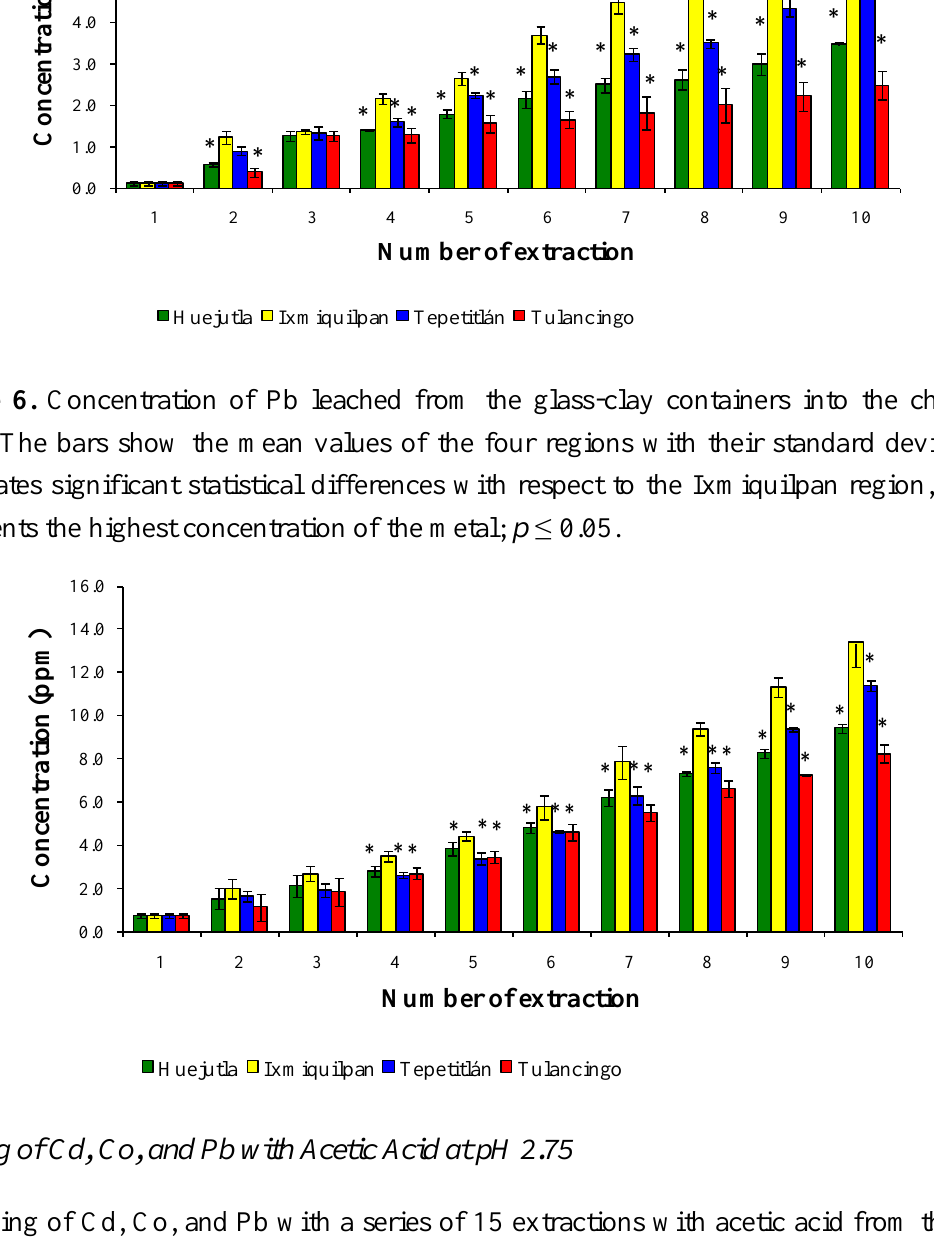
Figure 5. Concentration of Co leached from the glass-clay containers into the chickpea puree. The bars show the mean values of the four regions along with their standard deviations. * Indicates significant statistical differences with respect to the Ixmiquilpan region, which represents the highest concentration of the metal; p ≤ 0.05.